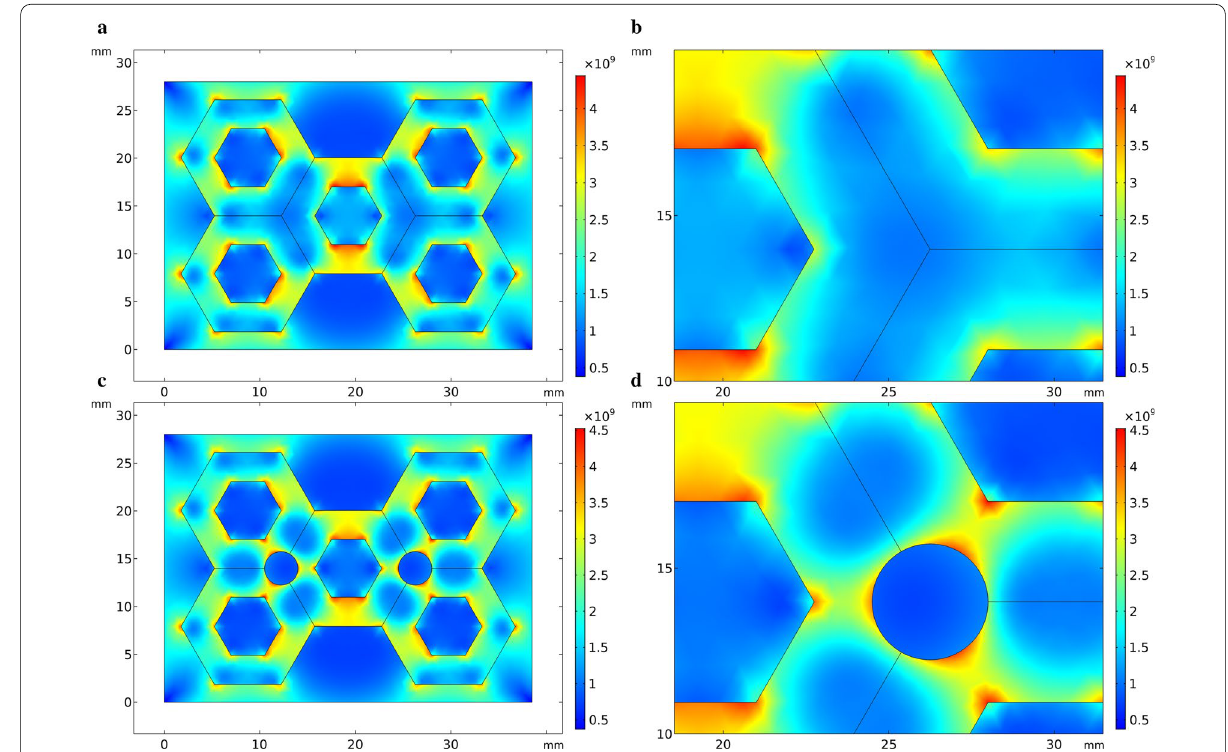
Fig.3 Thermal stress distribution during solidification in the simplified model. a Initial perform, b partial enlarged view of the initial perform, b preform with circular holes added, d partial enlarged view of the perform with circular holes